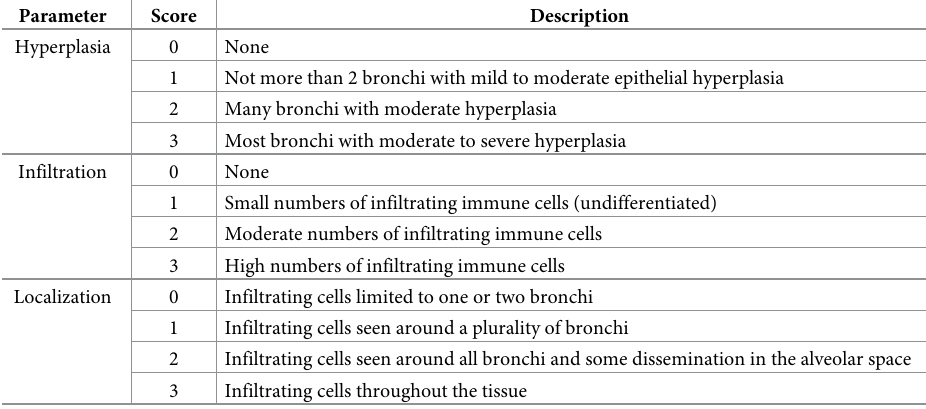
Table 1. Lung inflammation clinical score rubric. Parameter